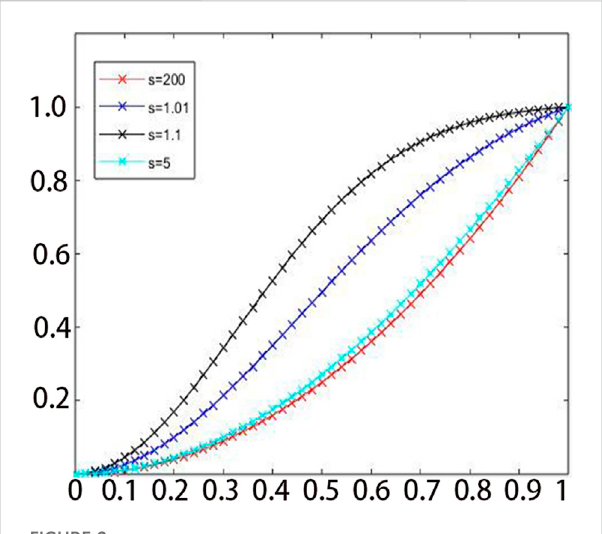
FIGURE 2 The curvature of the degradation function is controlled by the parameter s, corresponding to different change rates. For large s values, the change of degradation function is similar to that of traditional AT2